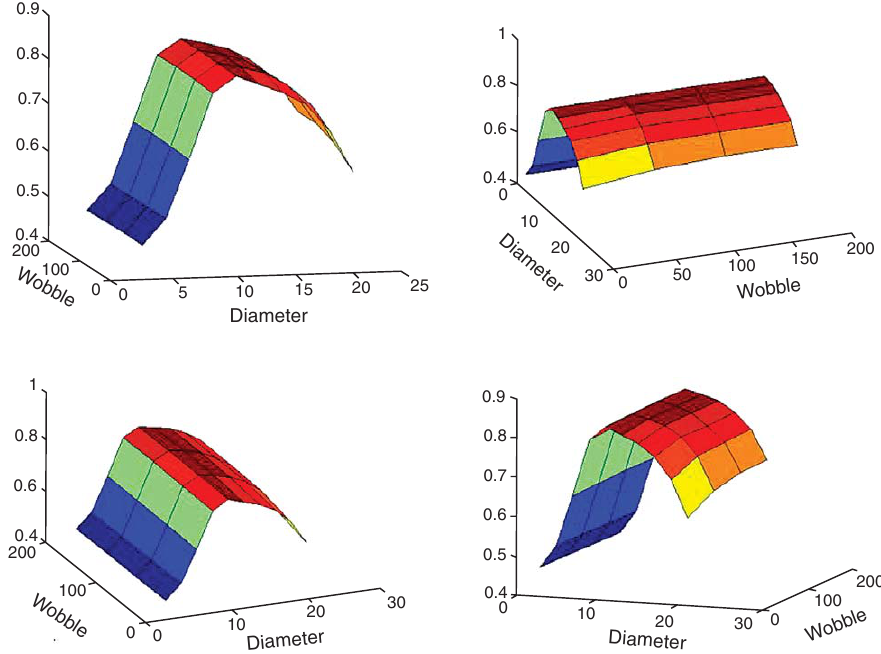
Fig. 5. Effect of ring size and wobble. Similar to Fig. 4, we explored the effect of ring size (from 3 to 23 pixels in diameter); however, we added an extra dimension of inter-ring “wobble”: no wobble (1), 60 degree, 120 degree, and maximal wobble (180 degrees). A ROCs was plotted across both dimensions of these parameters, resulting in a three dimensional curve, shown for clarity, here, with four rotational views (A–D). The bottom right figure shows best that the wobble angle had a minor increase on the ROC curves for those large rings between 0 and 120 degrees of “wobble”.